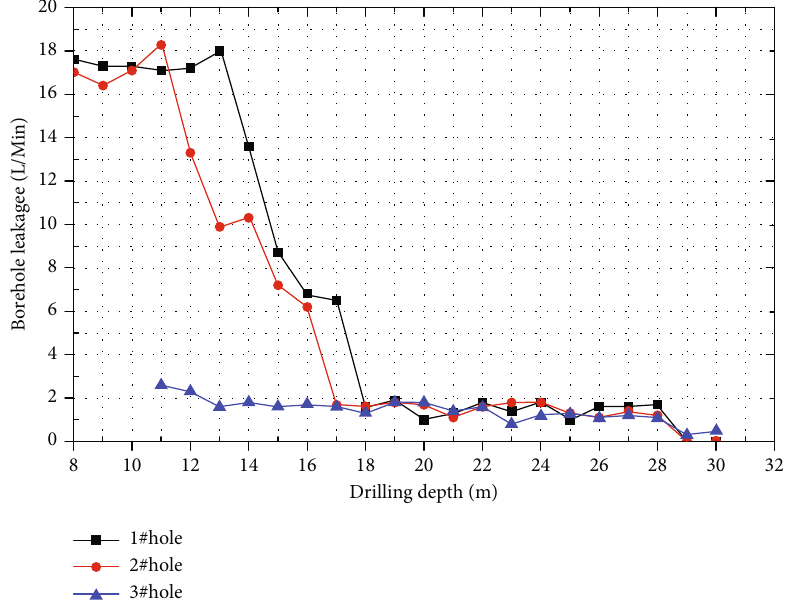
Figure 23: Amount of borehole water